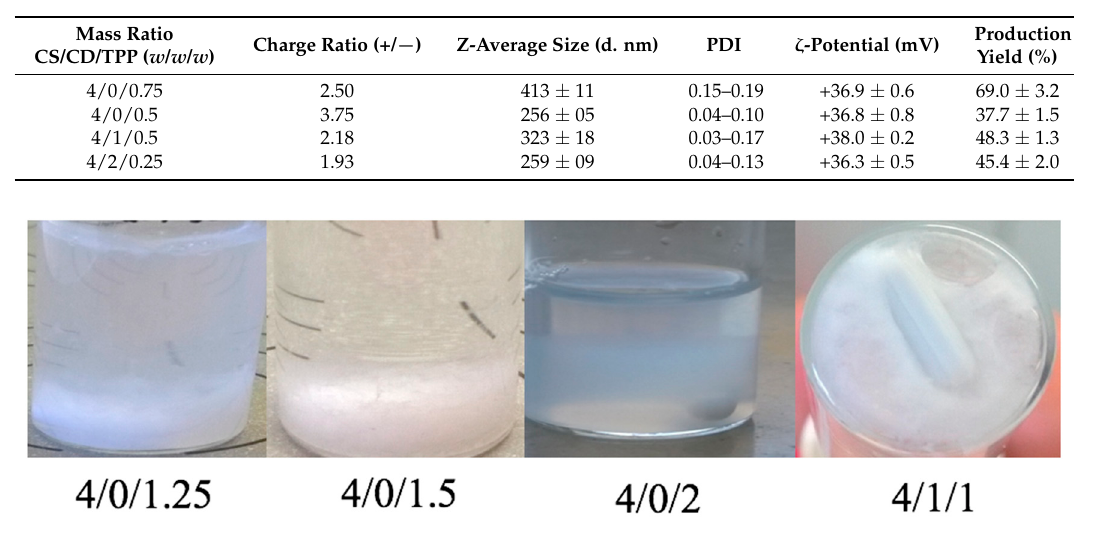
Figure 1. Appearance of CS 70/5 /SBE β CD nanoparticles showing a gel phase at the bottom of the vials that holds the magnetic stirrers. Table 1. Physicochemical properties of unloaded CS 70/5 /SBE β CD/TPP nanoparticles (mean ± S.D., n = 3).